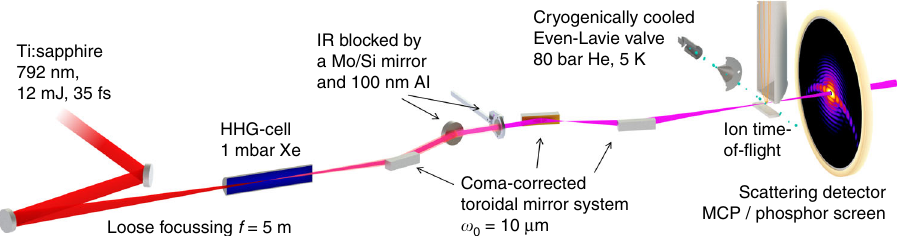
Fig. 1 Scheme of the experimental setup. A Ti:sapphire laser with 792 nm central wavelength and 35 fs pulse duration is used for the generation of high harmonics. Up to 12 mJ are loosely focused into a xenon- fi lled cell, where the extreme ultraviolet ( XUV ) pulses are produced. The copropagating near- infrared ( NIR ) beam is removed via a Mo/Si mirror and a thin aluminum fi lter. The beam is focused to a small spot ( ω 0 = 10 μ m) using a coma-correcting system of three gold-coated toroidal mirrors 26 . A pulsed jet of helium nanodroplets ( R ≈ 400 nm) is overlapped with the XUV focus. The overlap is optimized by monitoring the formation of He + ions using an ion time-of- fl ight spectrometer. The scattering signal is ampli fi ed by a pulsed MCP and converted to optical photons on a phosphor screen. The single-shot diffraction images are captured with an out-of-vacuum camera (not